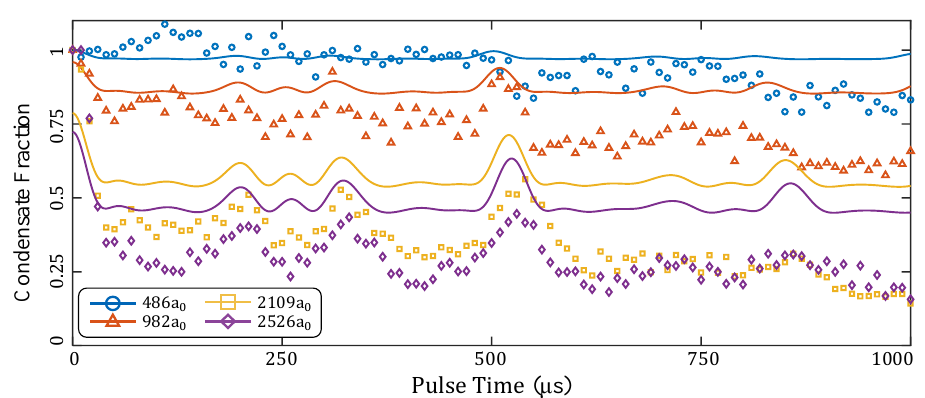
Figure 9: The condensate fraction at different interaction strengths (open symbols) with collision simulation results (solid line) for U cies between calculated results and experimental data indicate the continuing in-trap loss over